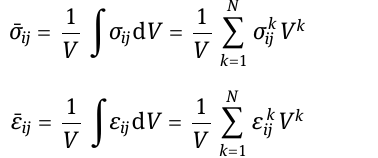
( Figure 5 ) . To make a comparison/verification of our com - putations, different analyses of comparable materials have been chosen from the literature. We decided to compare our findings with other simulations or experimental results, which related to a polymeric nanocomposite reinforced with a small amount of SWCNTs. The AC model presented by Alian et al. [ 42 ] indicates about 36% lower values of E A⁎ for ( 5,5 ) SWCNT concentration of 3% vol. in the epoxy matrix. Anjana et al. [ 28 ] also showed lower values ( 33%